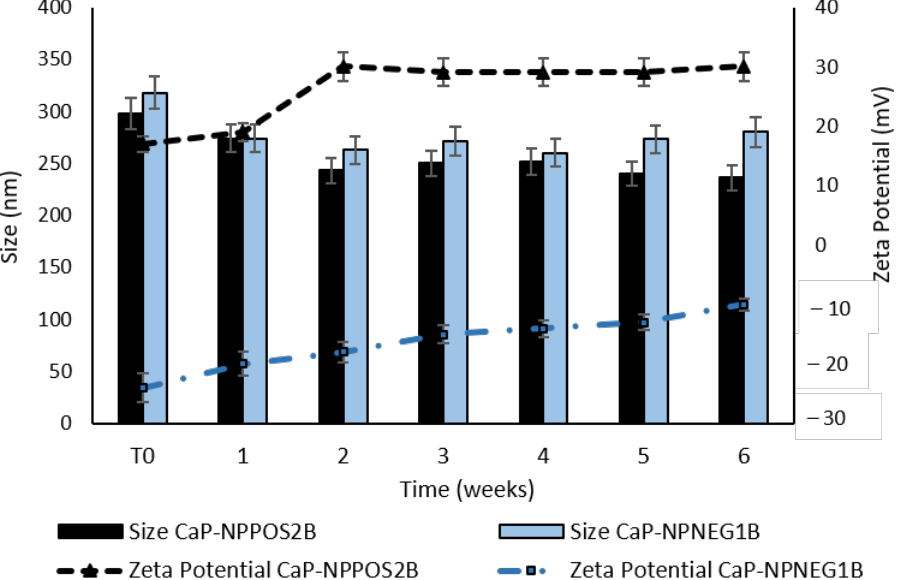
Figure 8. Overtime evolution of mean diameters and Zeta potential values of CaP-NP POS 2B and CaP-NP NEG 1B.